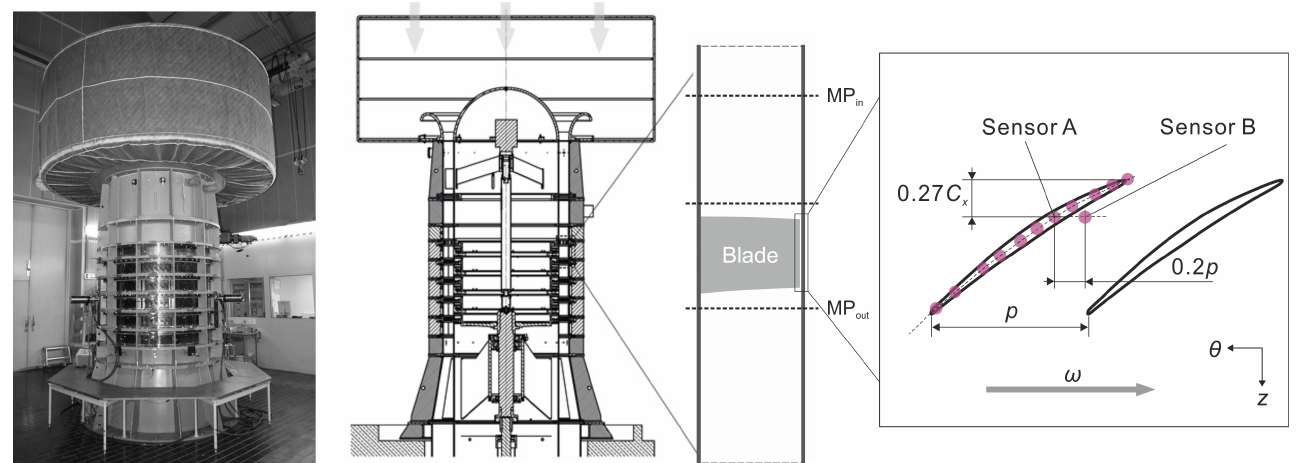
Figure 1. Investigated single rotor build-up of LSRC and arrangement of Kulite sensors on the wall.